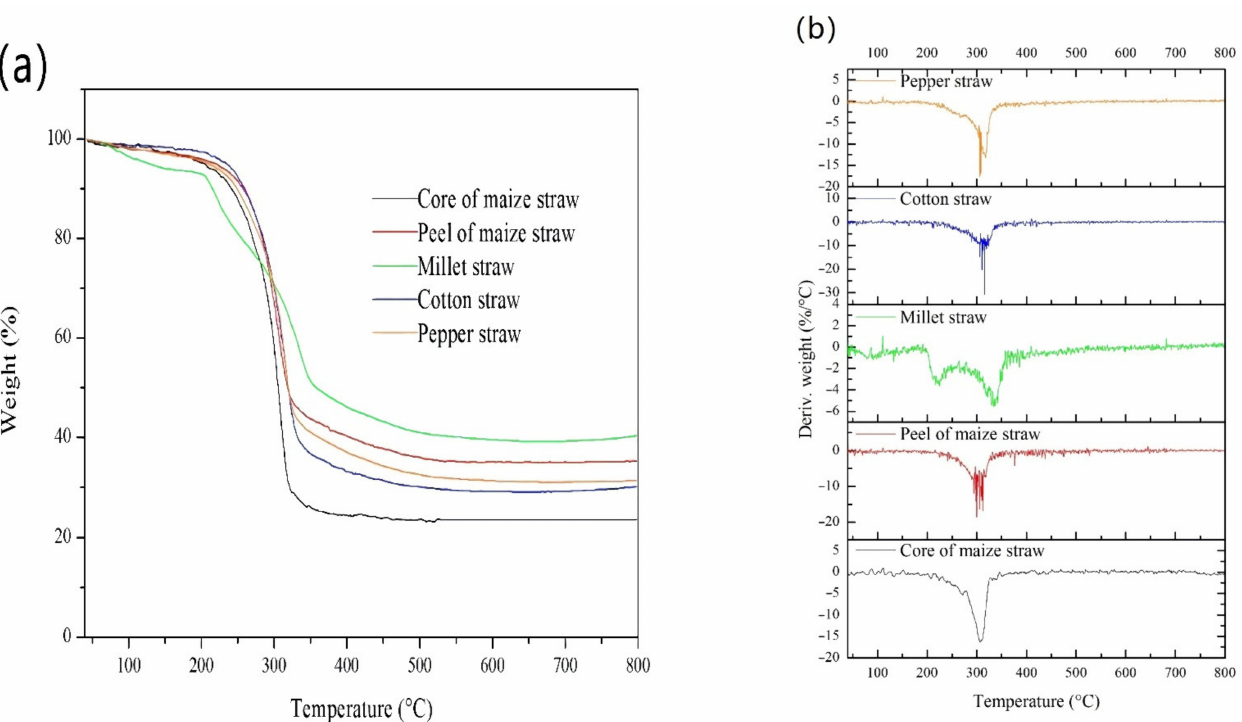
Figure 2. The pyrolysis behaviors of the five straws: ( a ) TG curves; ( b ) DTG curves. As for MS, the pyrolysis behavior was apparently different. The main second pyrolysis stage of MS was separated into two steps. One step occurred at 200–300 ◦ C with a weight loss of 22%, corresponding to the decomposition of hemicellulose. The other step happened at 300–350 ◦ C with a weight loss of 20%, which could be attributed to the decomposition of cellulose. It suggests that MS contains more hemicellulose components than the other four straws used in this